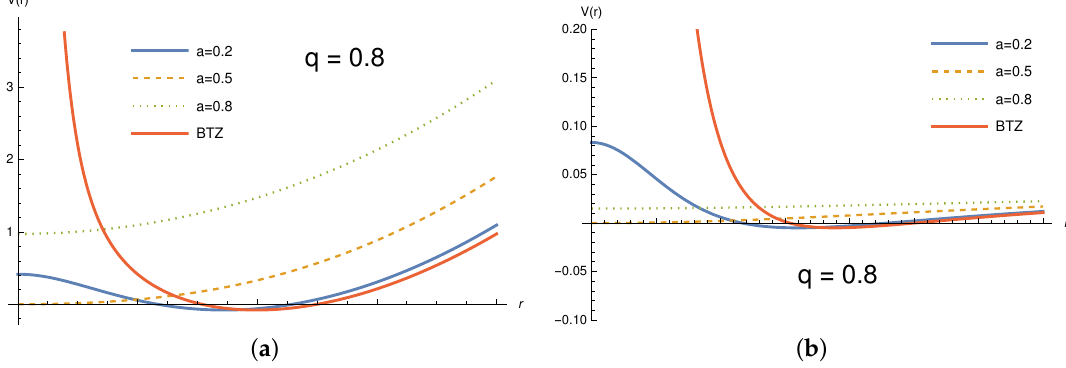
Figure 9. Plot of the effective potential for the Simpson–Visser charged BTZ black hole. ( a ) stands for massive particles while ( b ) is for photons. We used for this plot M = 1, l = 0.5, and L = 0.1. ( a ) stands for q = 0.3 and ( b ) stands for q =